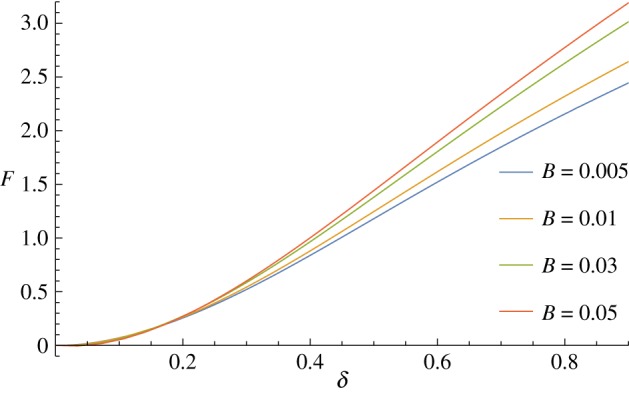
Changing the bending/stretching ratio β with the full theory, ξ=1, increases the force required to indent the shell and removes the negative values of the force as seen for ξ=0. (Online version in colour.)